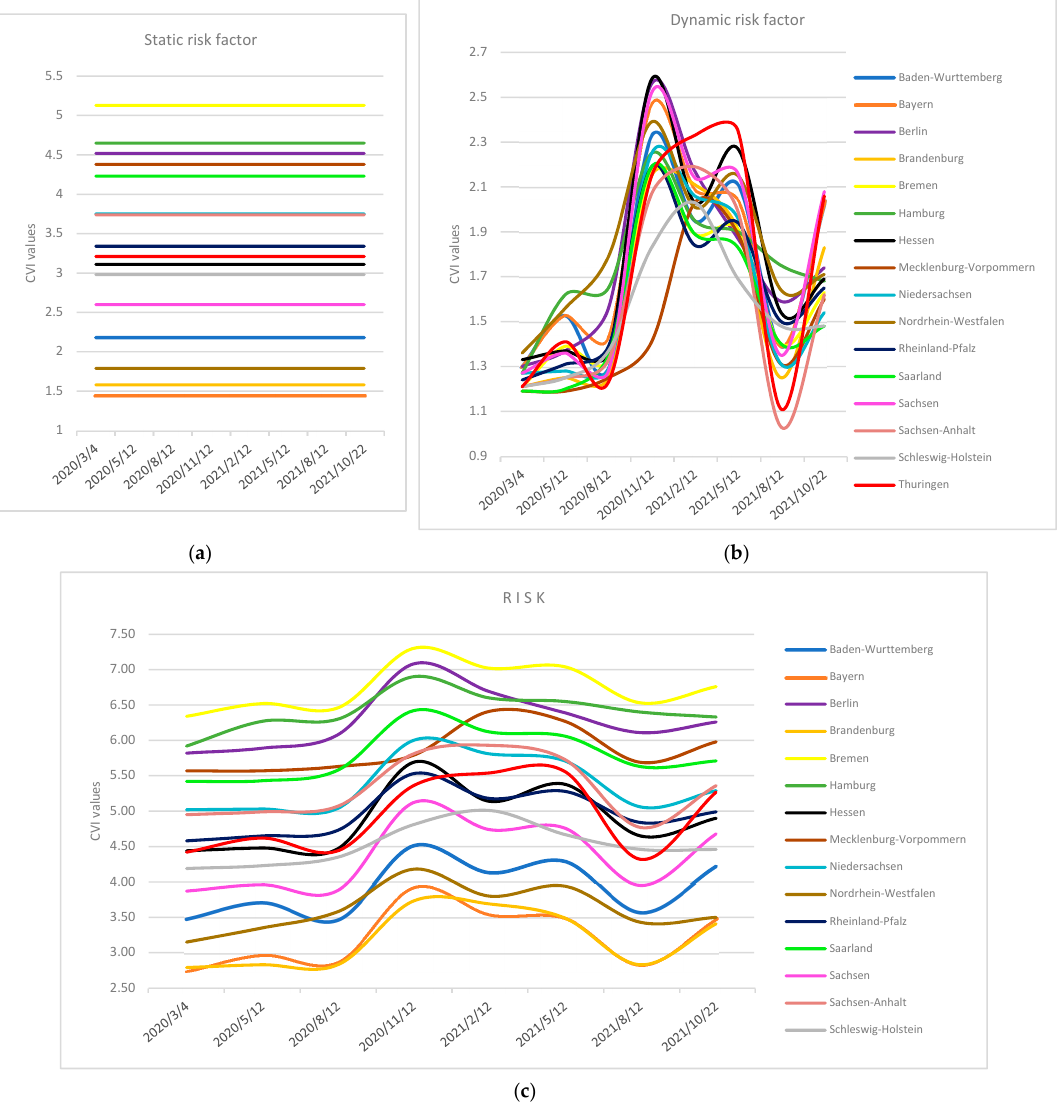
Figure 13. The static ( a ) dynamic ( b ) static and (c) summary vulnerability risk for each federal state on selected days .